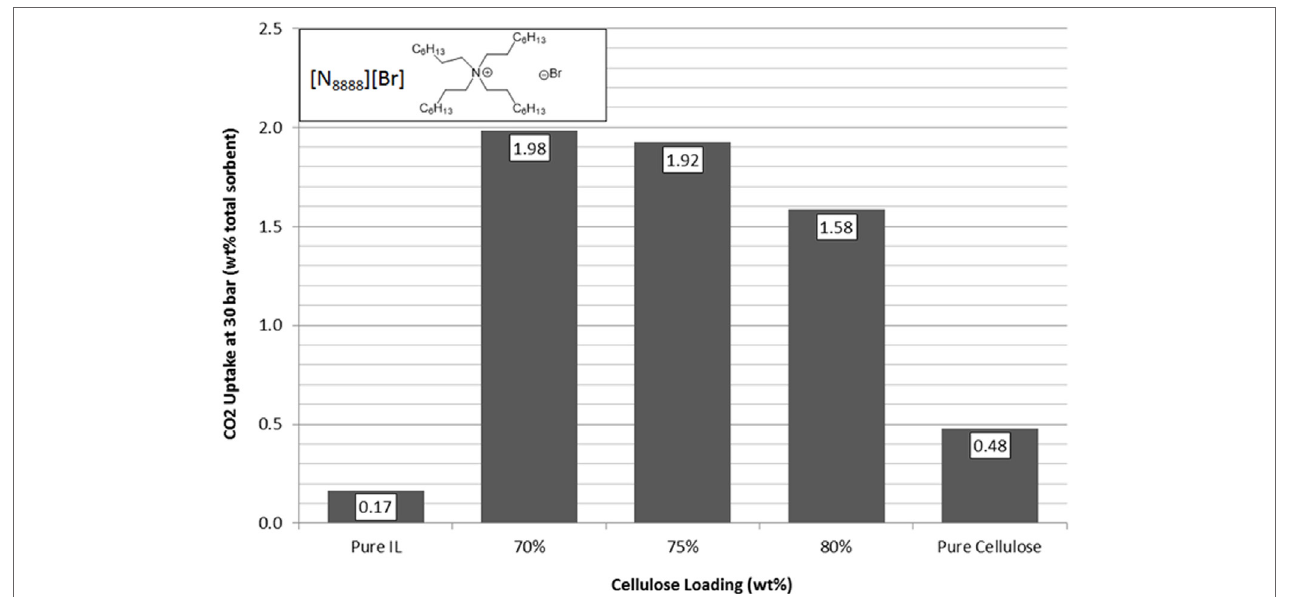
FigUre 10 | Trends in total sorbent CO 2 uptake at 30 bar of [N 8888 ][Br] as a function of cellulose loading at room